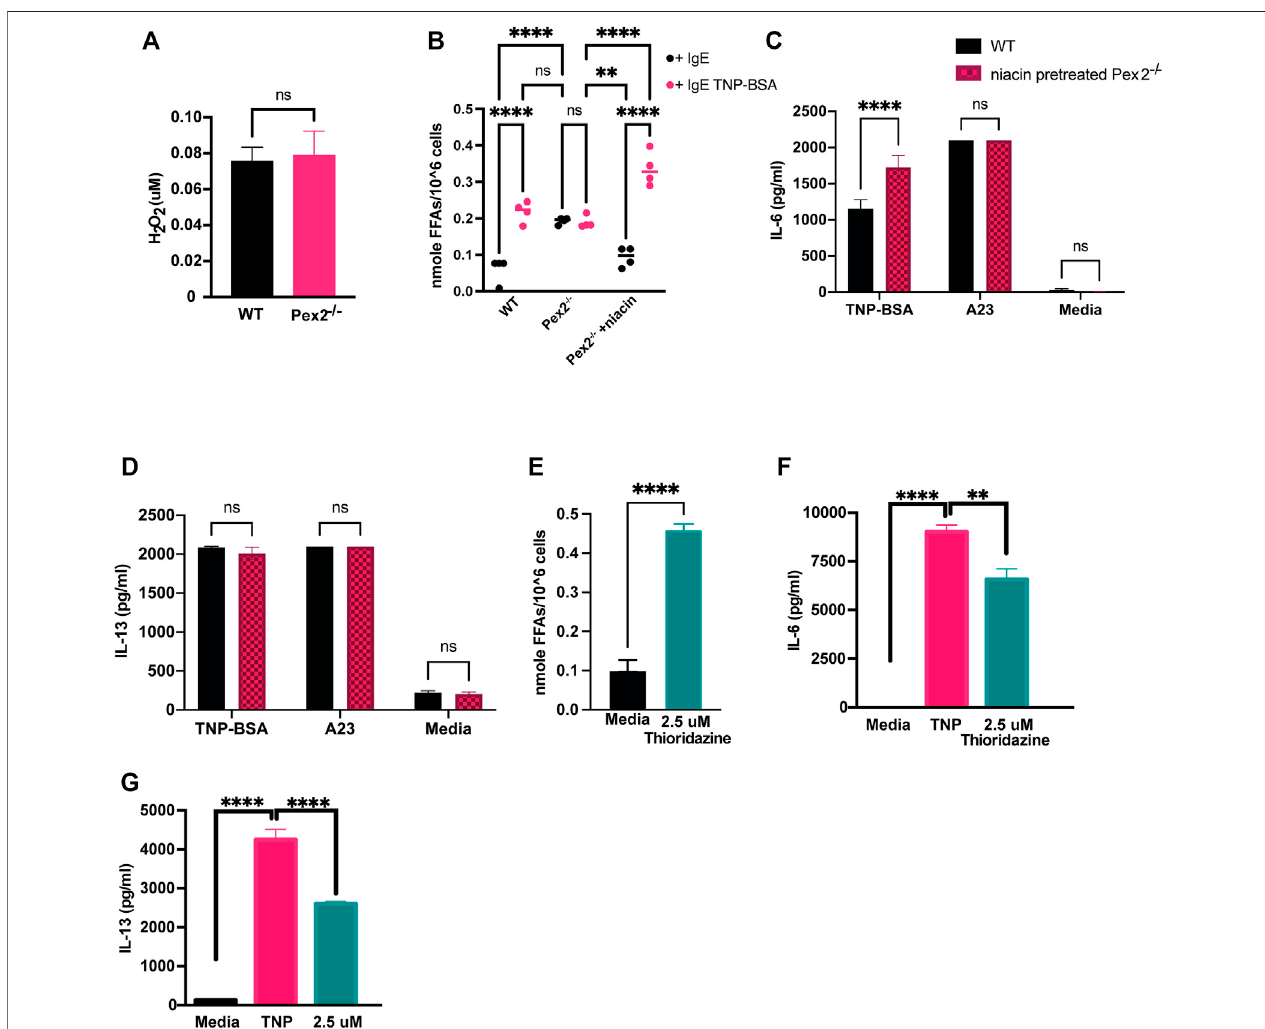
FIGURE3| DefectsinperoxisomalfattyacidmetabolismaffectscytokinesreleaseinMCs: (A) WTandPex2 − / − BMMCspelletswereassessedforthelevelofH2O2 and (B) freefattyacidsatbaselineandafter24 hIgEmediatedactivationwithTNP-BSAinWT,Pex2 − / − andniacin-treatedPex2 − / − BMMCs. (C,D) ConcentrationsofIL- 6andIL-13wereassessedafter48 hofniacintreatmentfollowedby24 hIgEorA23activation. (E) FreefattyacidsamountsmeasuredinWTBMMCatbaselineandafter 24 h oftreatment with thioridazine. (F – G) Effectof free fatty acid metabolism inhibition on IgE-mediated IL-6 and IL-13 release wasassessed in C57BL/6 BMMCs. The media column in graphs C-G represent the baseline level detected for each cytokine. The graphs represent the average of three independent experiments ±SEM. Statistical analysis was performed using a non-parametric t -test comparing between Pex2 − / − and WT BMMCs. ** p < 0.001, *** p < 0.0001, **** p < 0.00001, ns: not signi fi